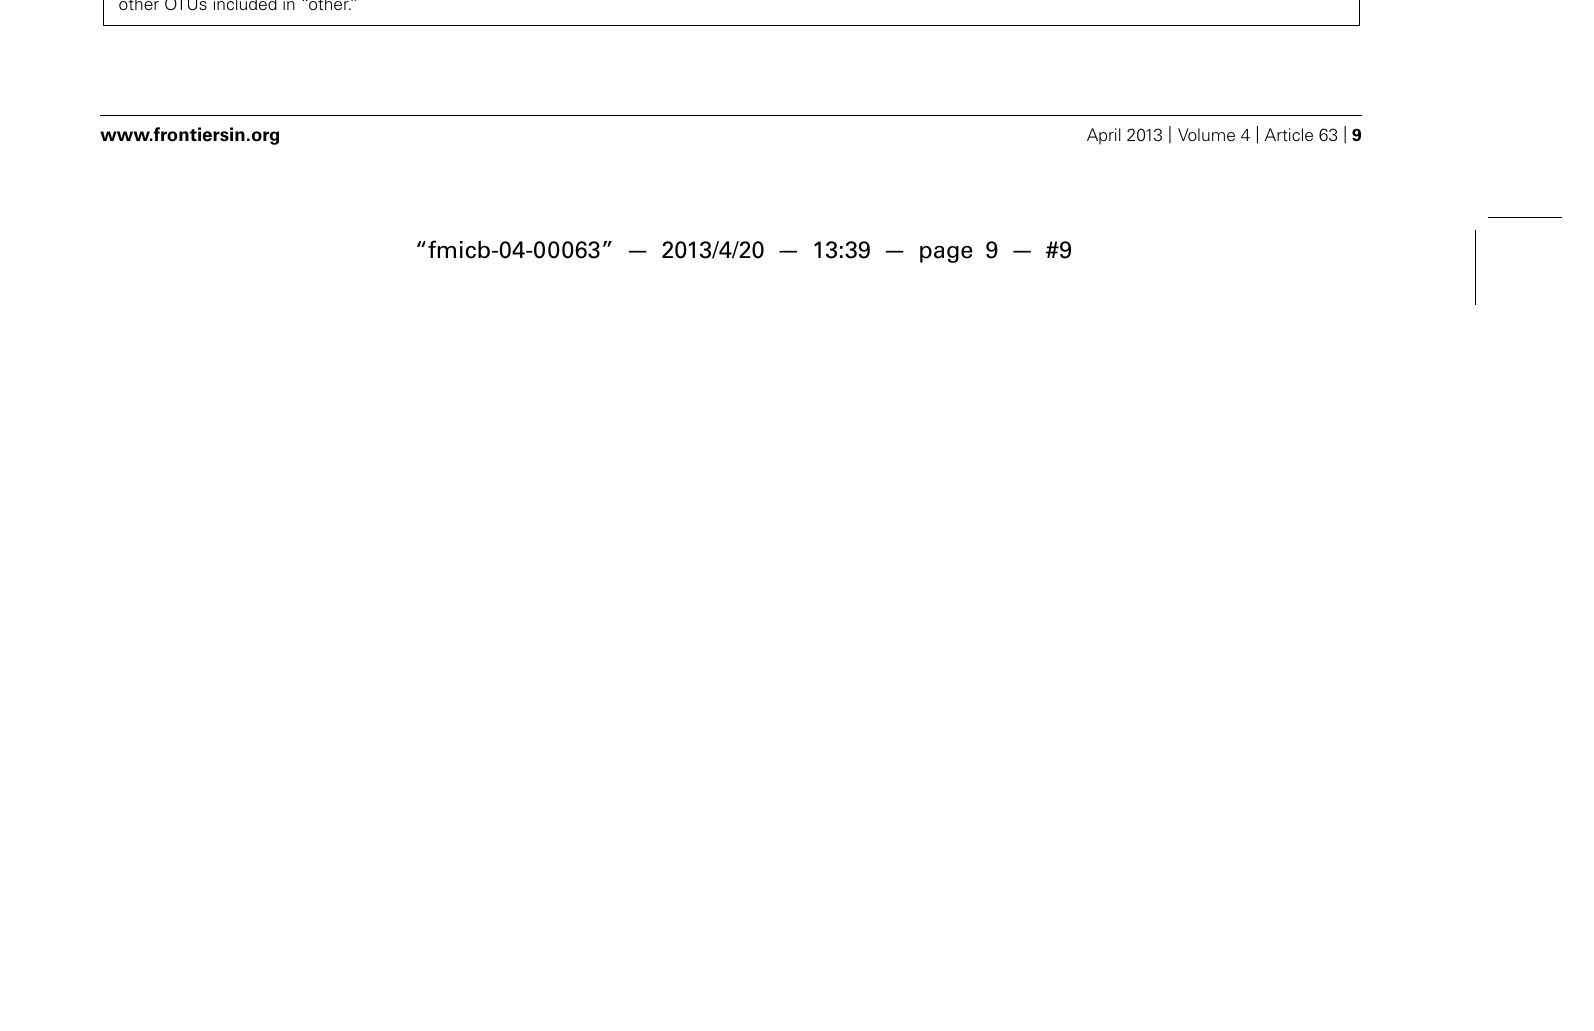
FIGURE 3 | SSU rRNA gene sequence data from the PCR amplicon library. (A) The SSU rRNA data at the phylum level, except that the proteobacteria have been split into classes. Phyla which are less than 0.01% in all samples are included in “other.” (B) Each OTU representing more than 5% of any sample, with all other OTUs included in